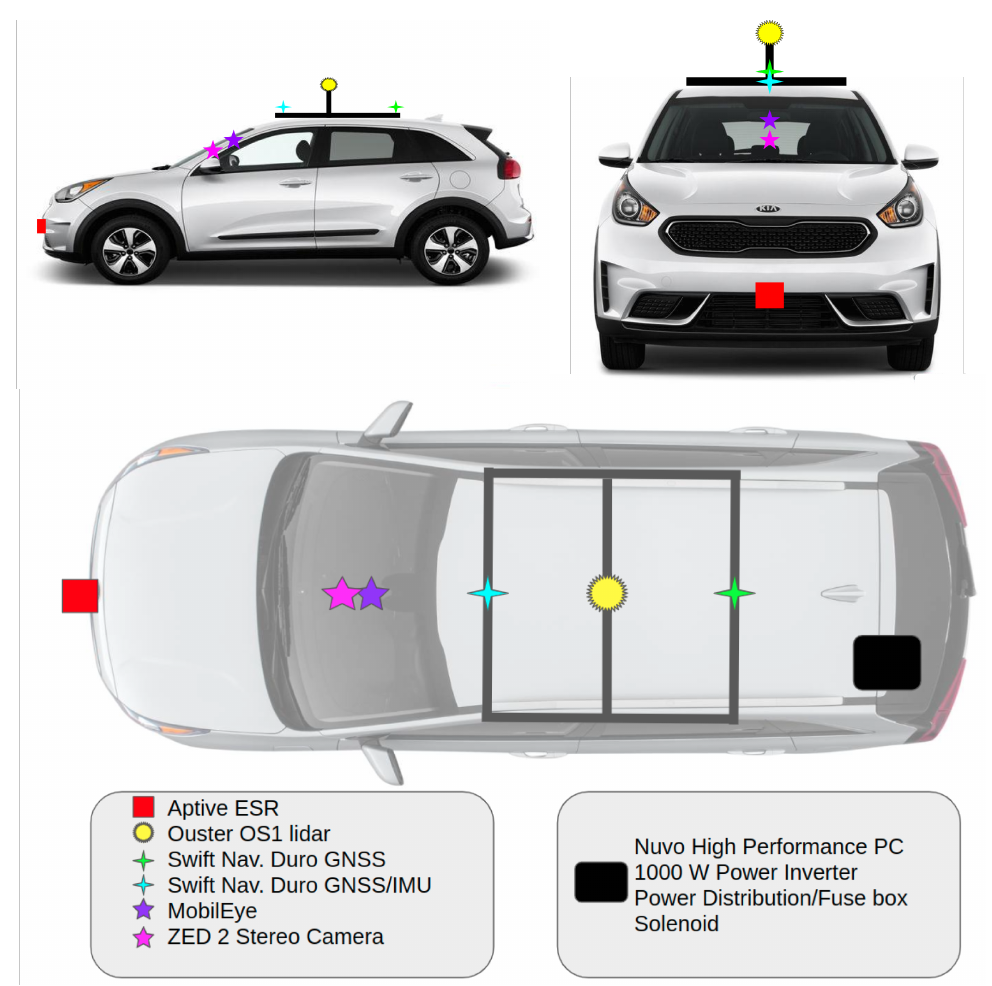
Figure 2. Sensor and hardware placement for autonomous integration side, front, and bird’s-eye view. Image sourced from